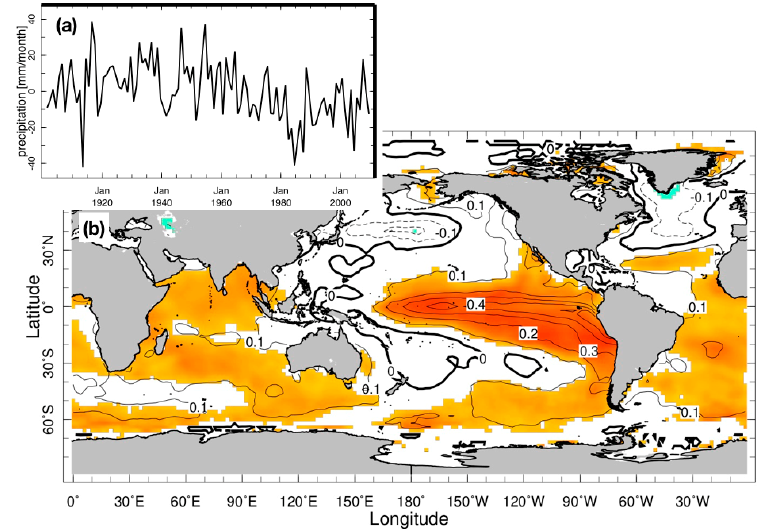
Figure 6. In ( b ) is the regression of global SST on a time series representing monsoon season (June–September) rainfall in the Ethiopian Highlands, which contains the origins of the Blue Nile and Atbara River. The rainfall was averaged in the box: 30–38° E and 8–16° N and is shown in ( a ). Regression contours are drawn every 0.1 °C per one standard deviation of the rainfall time series. The area where the regression is significant ( α ≤ 5%, two sided, based on the local correlation) is highlighted in color, with blue indicating negative and orange positive values. The darker the value the large is the significance.